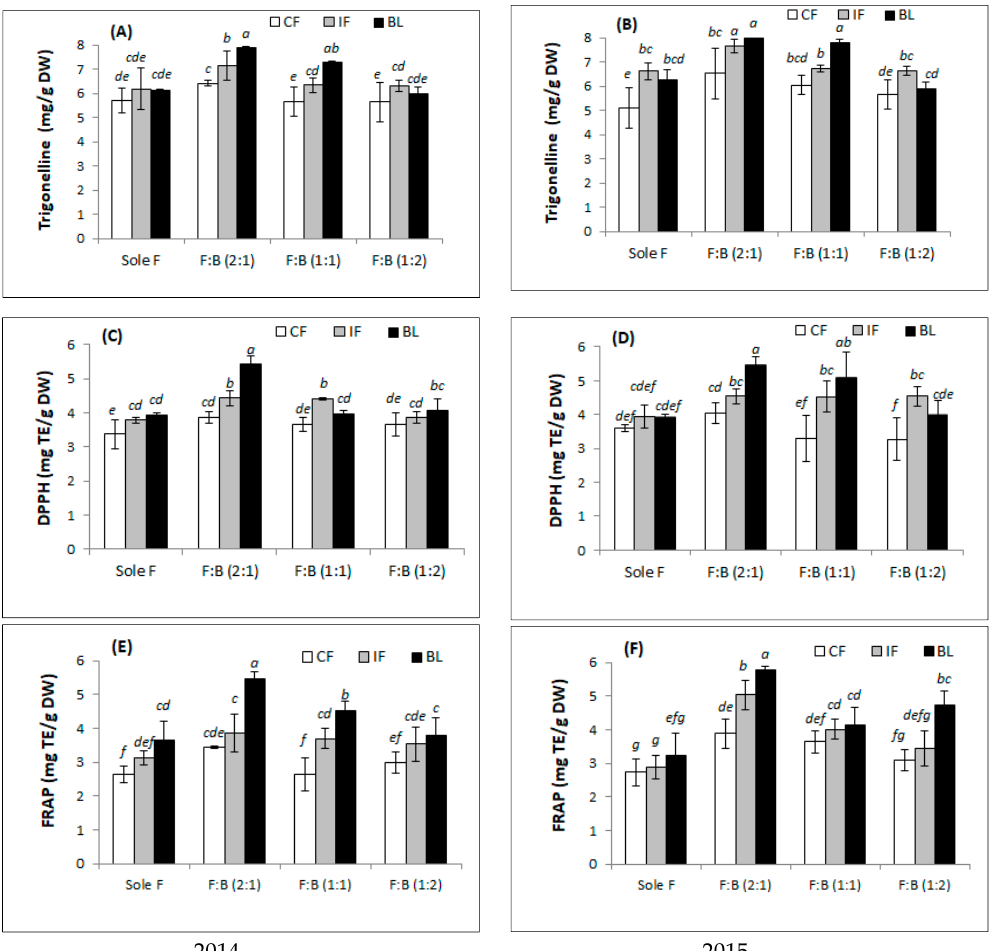
Trigonelline content ( A , B ), and antioxidant activity estimated by 2,2-Diphenyl-1- Picrylhydrazyl (DPPH) ( C , D ) and Ferric reducing antioxidant power (FRAP) ( E , F ) assays of fenugreek seeds as affected by cropping system × fertilizer types interaction in 2014 and 2015. chemical fertilizer (CF), integrated fertilizer (IF), broiler litter (BL), sole fenugreek (Sole F), F:B = 2:1, F:B = 1:1 and F:B = 1:2 are chemical fertilizer, integrated fertilizer, broiler litter, sole fenugreek, two rows of fenugreek + one row of buckwheat, one row of fenugreek + one row of buckwheat, and one row of fenugreek + two rows of buckwheat, respectively. Different letters indicate significant differences at p < 0.05 by the least significant differences (LSD) test.